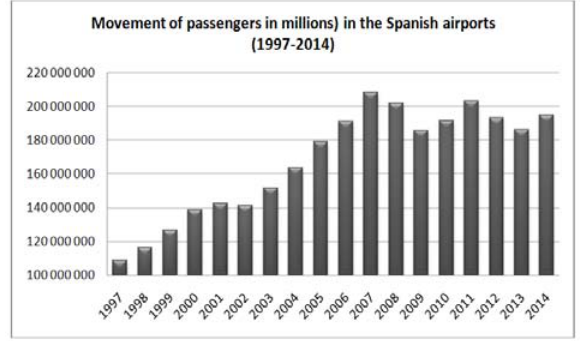
Fig. 1. Movement of passengers (in millions) in the Spanish airports